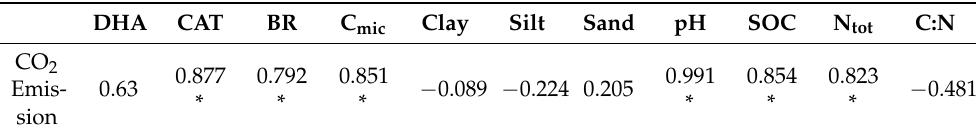
Table 4. Correlation coefficients between the CO 2 emission and the microbial and physicochemical parameters of soils from the top, mid-slope, and bottom of the forest gully (asterisk indicates significant differences at p <